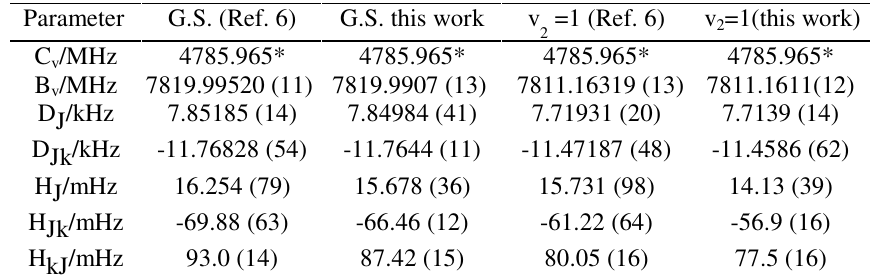
in ground and v = 1 state. 3 2